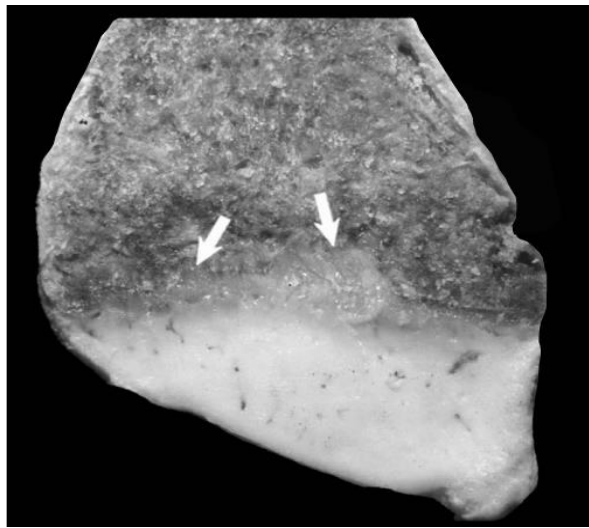
Figure 3. Costochondral junction from a 1-year-old Qianbei-Pockmarked goat with phosphorus deficiency. White arrows indicate tongues of cartilage extending into the metaphysis of a costochondral junction.